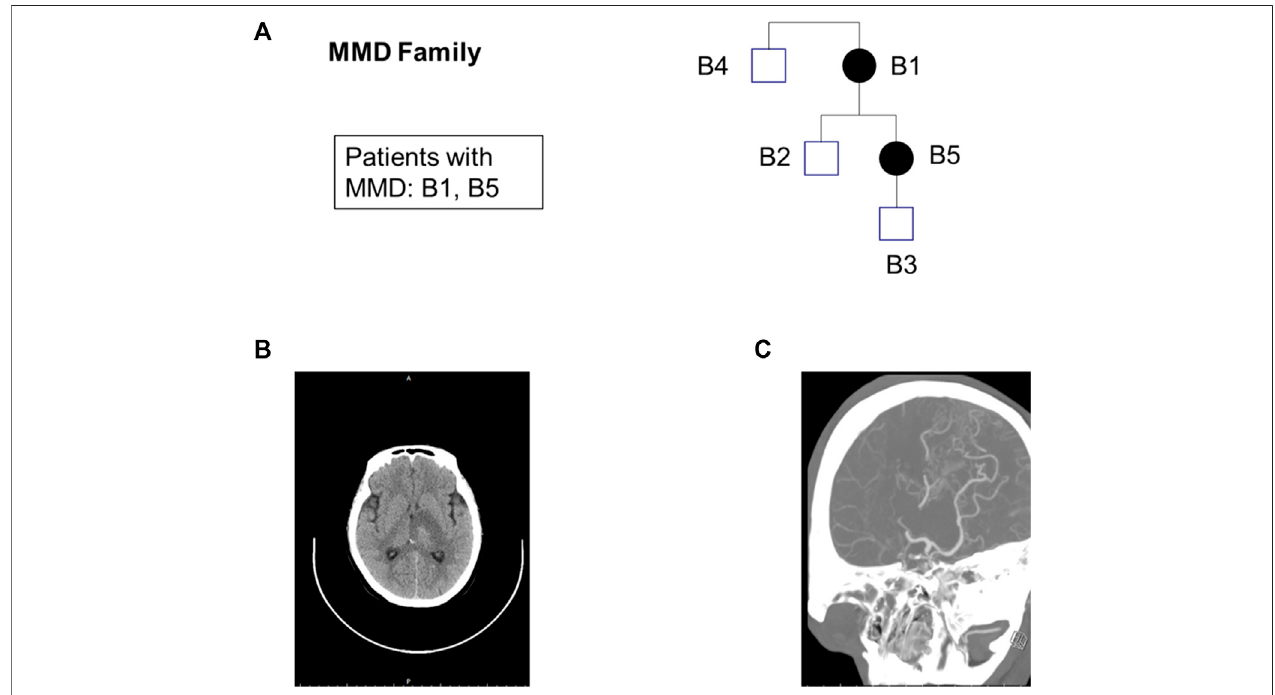
FIGURE 1 | Exome sequencing maps for the MMD family. (A) Pedigree charts. Squares: male; circles: female; black- fi lled symbols: patients; (B) CT of patient B1; (C) CTA (Computed Tomography Angiography) of patient